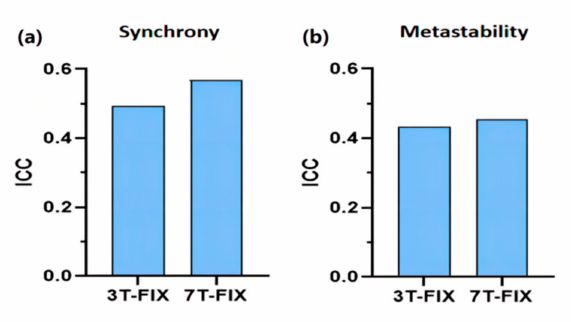
Figure 2. Reliabilities of synchrony ( a ) and metastability ( b ) in different magnetic flux strength strategies, evaluated by the intraclass correlation coefficient (ICC).